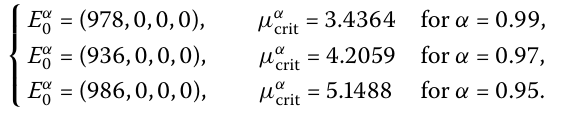
= 2.4 α (left panel) and μ α = 7.4 α (right panel) for V V , T 0 , V 0 ) = L A